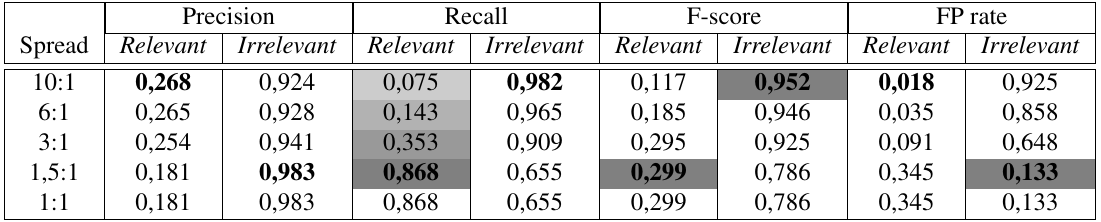
Table 7: Results of BN classifier for category G when applying different spread for random un- dersampling.